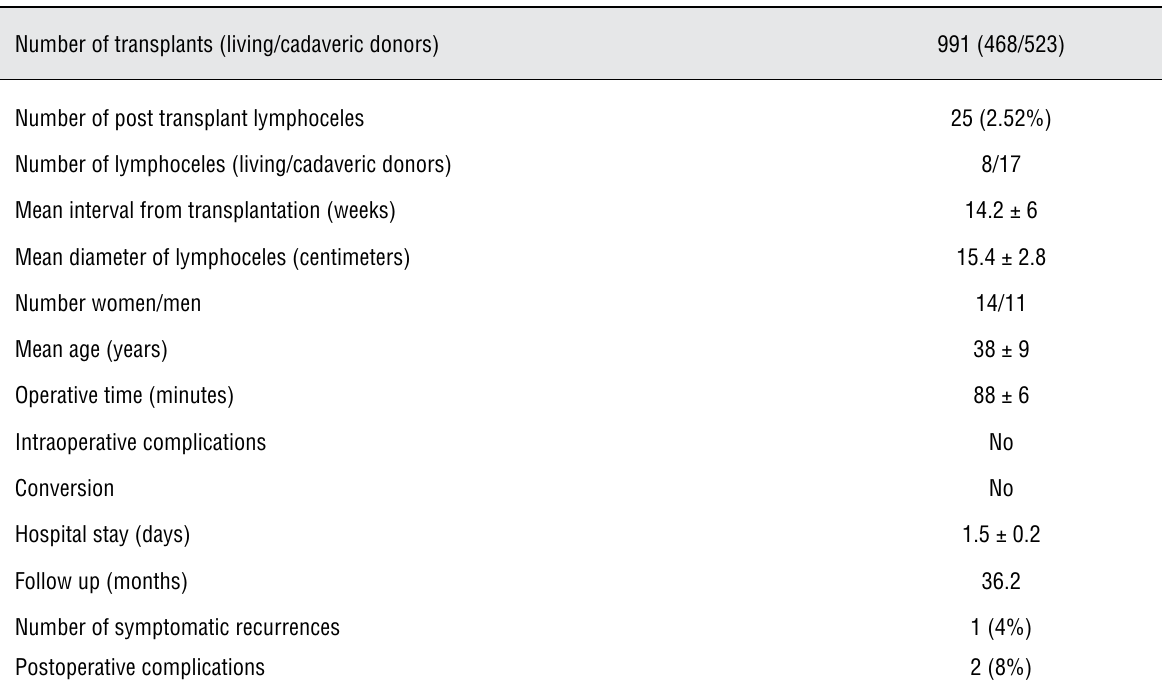
Table 1 - Patient